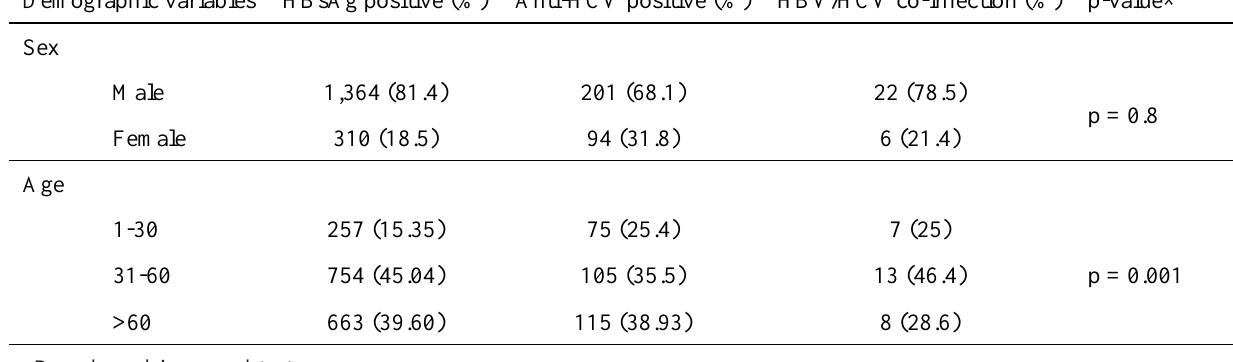
Table 1. Demographic data on HBV/HCV distribution in the study population. transaminase (AST), Alkaline Phosphatase (ALP), bilirubin total (BT), bilirubin indirect (BI), and bilirubin direct (BD) were 114.4±403.8 IU/L, 94.7±344.8 IU/L, 101.4±71.6 IU/ml, 1.4±2.9mg/dl, 0.7±2.7mg/dl, and 0.7±1.7mg/dl respectively in HBsAg positive patients, and 100.25±201.4 IU/L, 106.3±265.7 IU/L, 114.7±65.9 IU/ml, 1.7±2.7mg/dl, 1.05±2.7mg/dl, and 0.7±0.7mg/dl respectively in HBV/HCV co-infected patients. Levels of ALT, AST, ALP, and bilirubin were significantly different between HBV/HCV co-infected patients and HBsAg mono-infected patients (p <0.001)